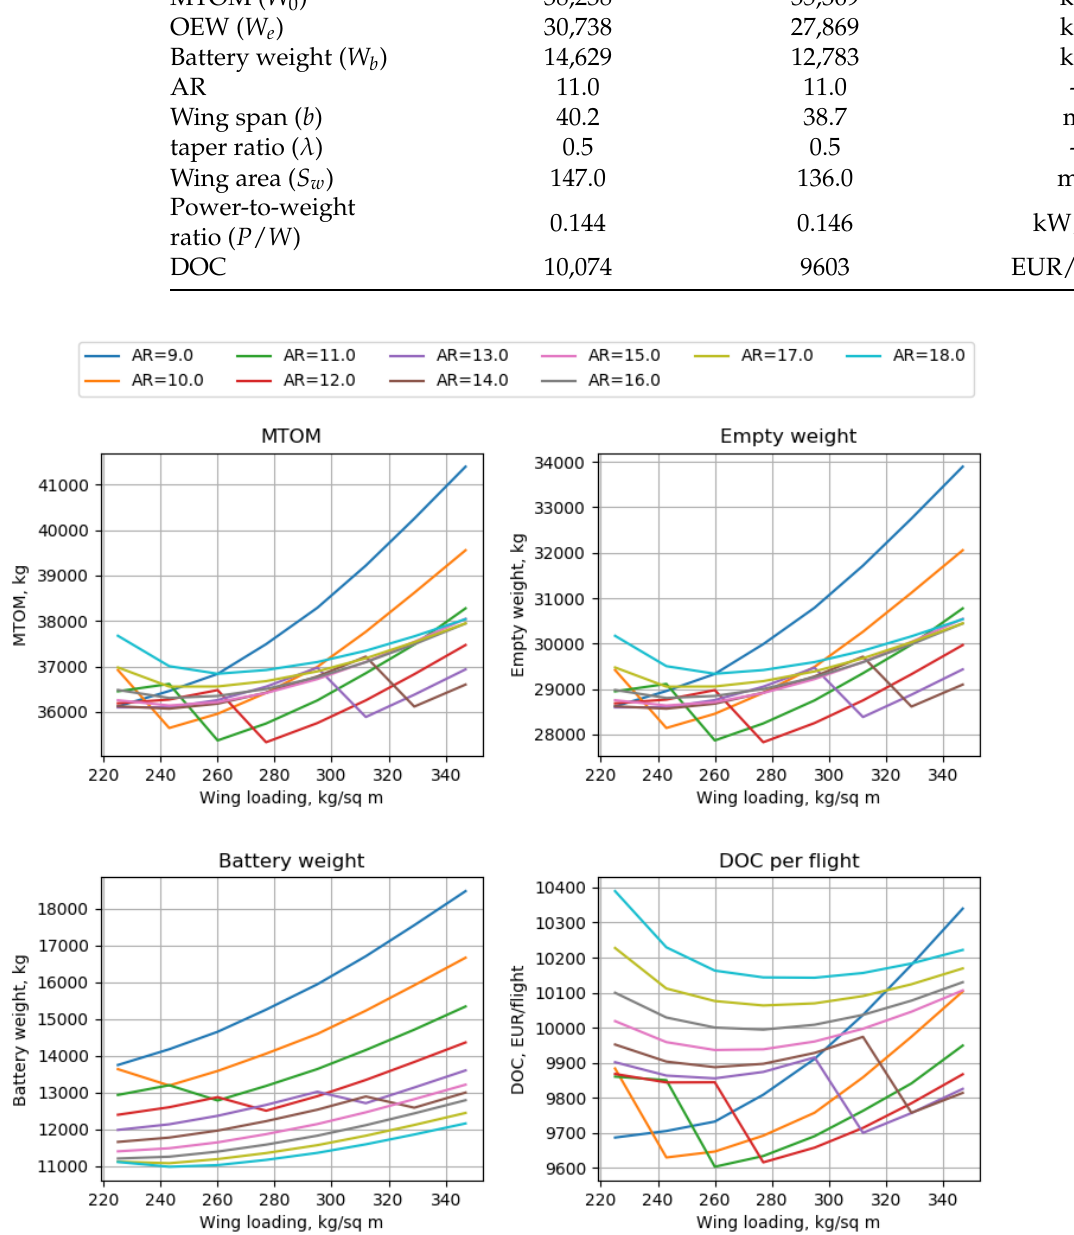
Figure 11. Sensitivity of weights and DOC to the aircraft AR and wing loading for the low-wing configuration (pack energy density of 700